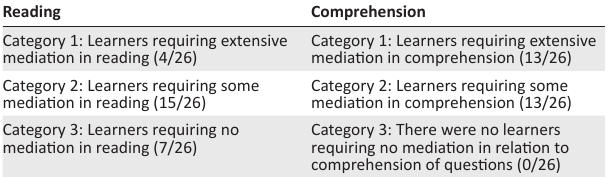
TABLE 1: Learners’ performance in reading and comprehension